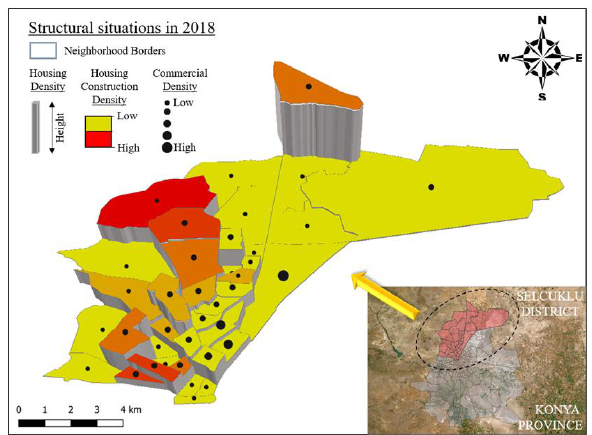
Figure 8. Spatial distribution of Structural data for 2018 The purchase-sale density map of 2012 and 2018, obtained from the parcel inquiry application of The General Directorate of Land Registry and Cadastre, are given in Figure 9 and Figure 10.